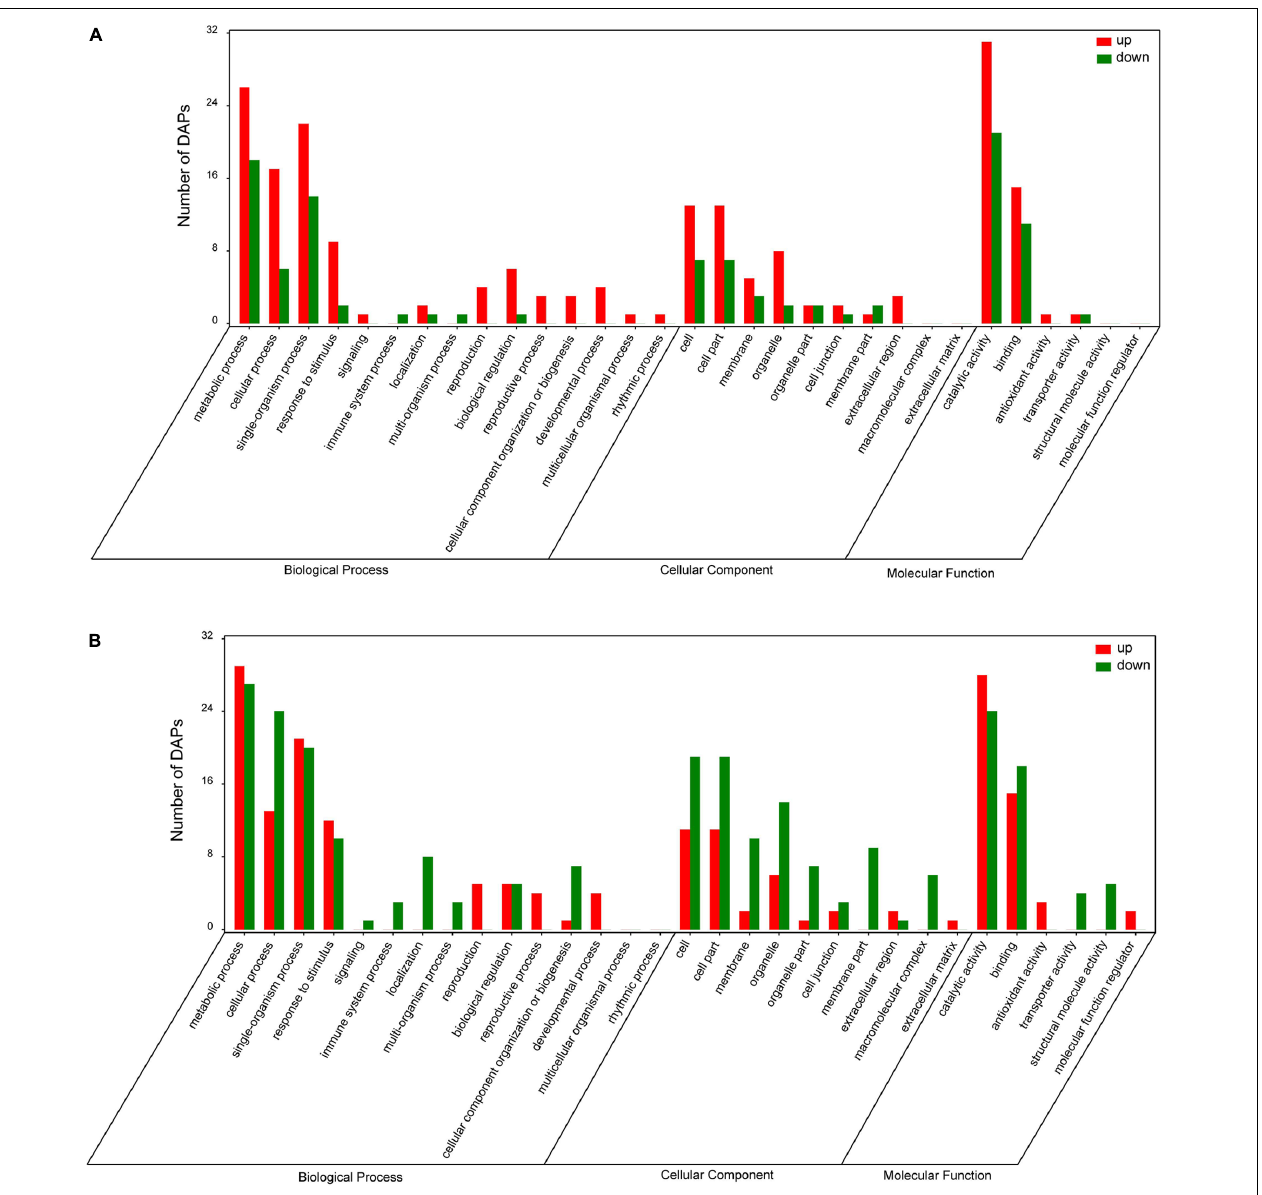
FIGURE 5 | Gene Ontology (GO) analysis of DAPs in roots of Medicago sativa L. cv. Longzhong (A) and cv. Gannong No. 3 (B) under PEG-induced osmotic stress (red and green bars represent up- and down-regulated proteins, respectively).